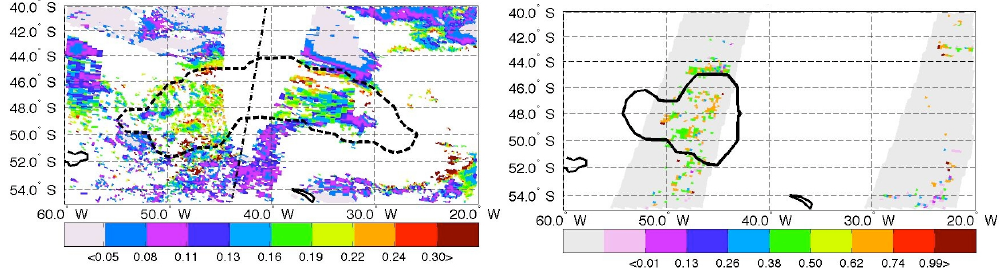
Fig. 9. Same as Fig. 7 but for the day after of the dust event (27 February). GLAS pass (N-S dashed line) was at ∼ 18:20UTC. The MODIS images are composed out of two successive orbits in the region ( ∼ 11:20 and 13:00UTC). Figure 9: Same as Figure 7 but for the day after of the dust event (February 27). GLAS pass (N-S dashed line) was at ~18:20 UTC. The MODIS images are composed out of two successive orbits in the region (~11:20 and 13:00 UTC).